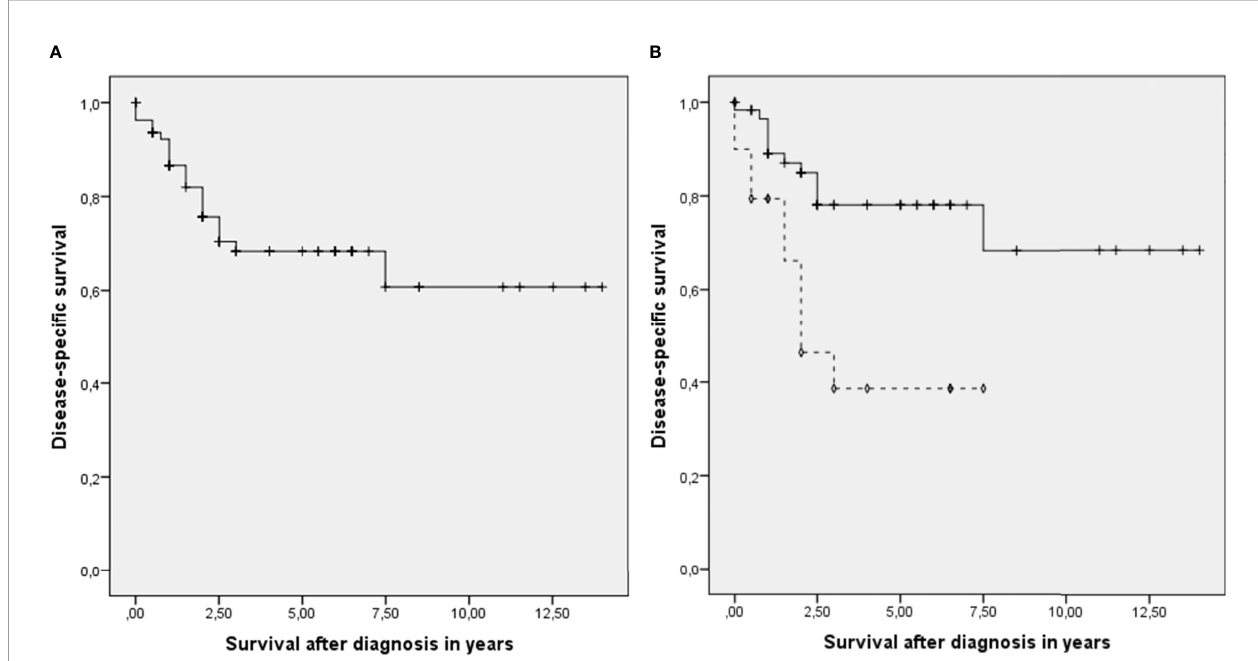
FIGURE 1 | (A) Disease-speci fi c survival for all patients with metastasis of head and neck cutaneous squamous cell carcinoma. + censored. (B) Disease-speci fi c survival divided between patients ≤ 2 ( — ) histopathological positive lymph nodal levels at time of surgery and patients with > 2 (---). +, ◊